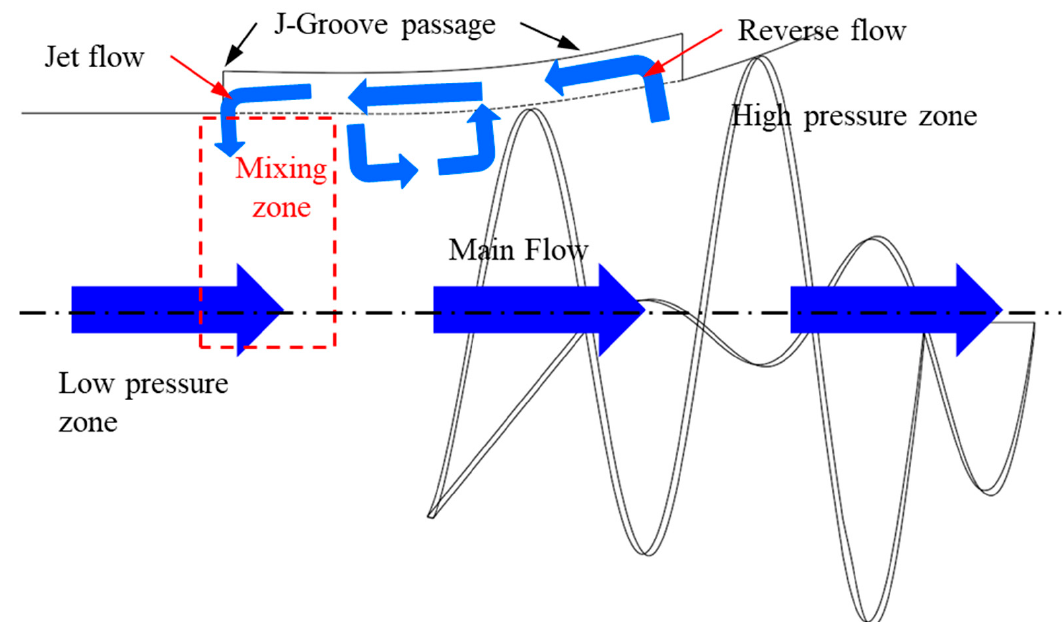
Figure 26. Mechanism of reverse flow in SCP model with J-Groove.